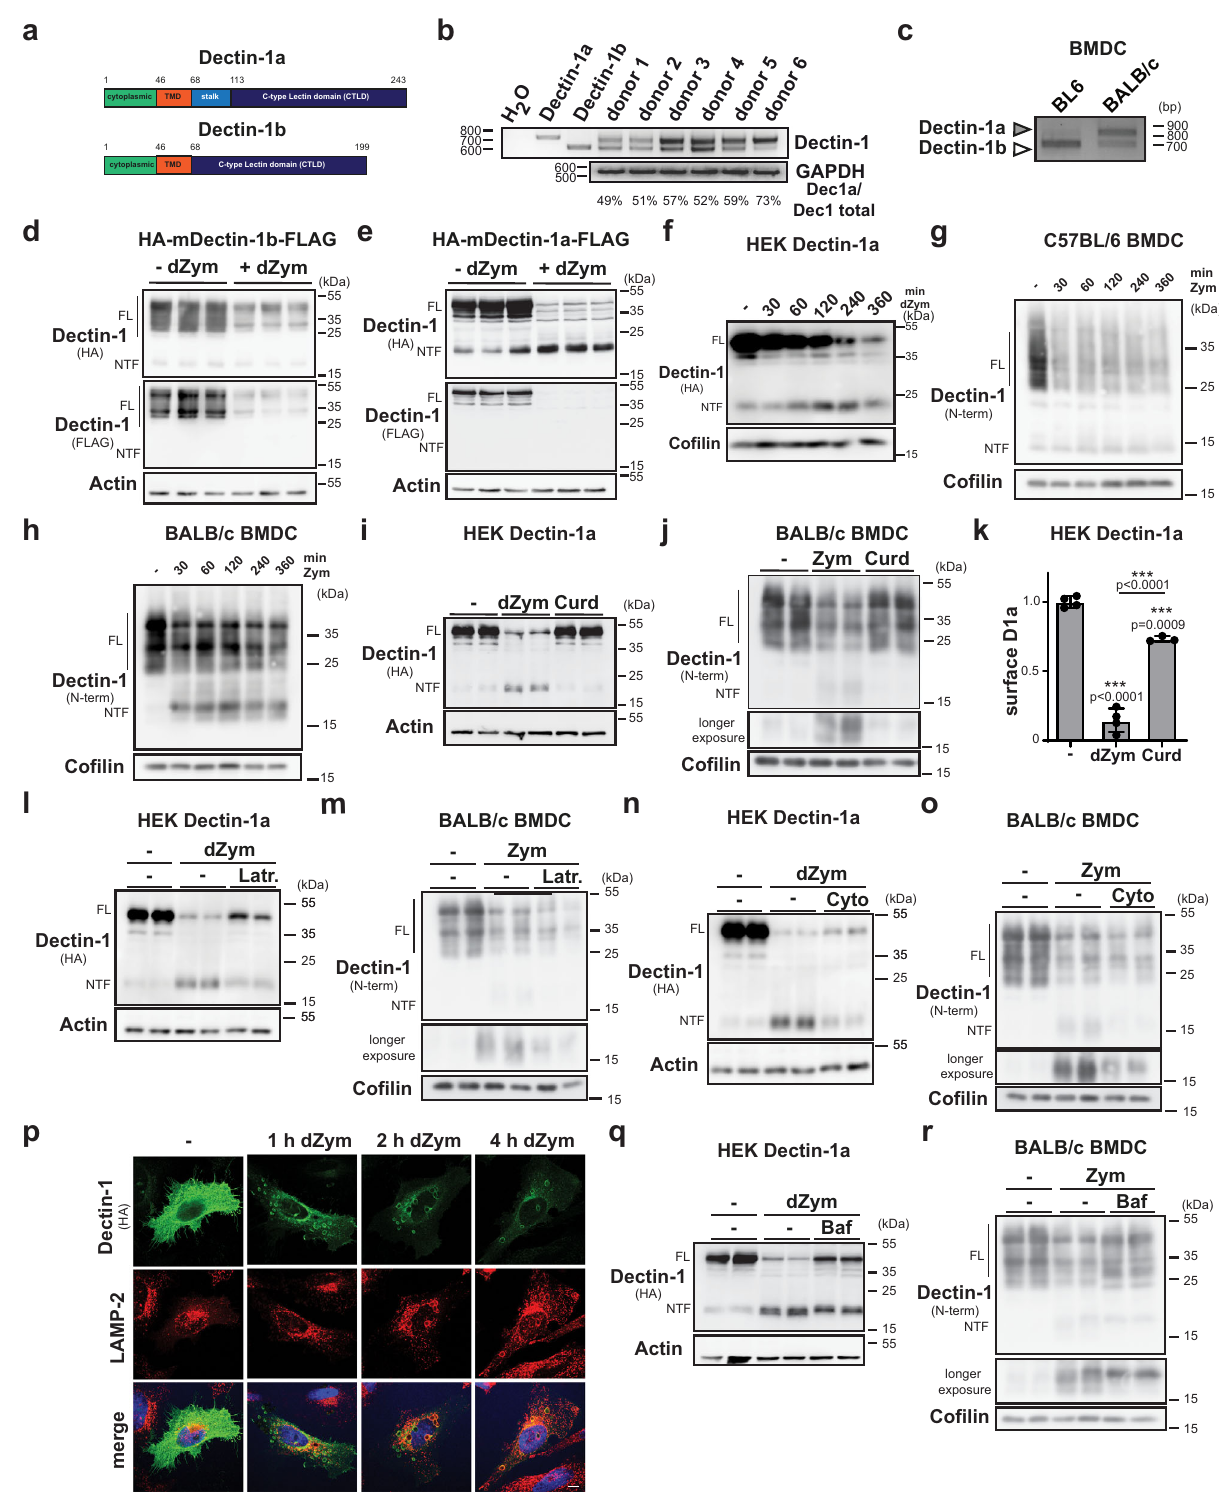
Dectin-1 degradation in bone marrow-derived dendritic cells (BMDCs) from BL6 (Fig. 1g) and BALB/c mice (Fig. 1h),